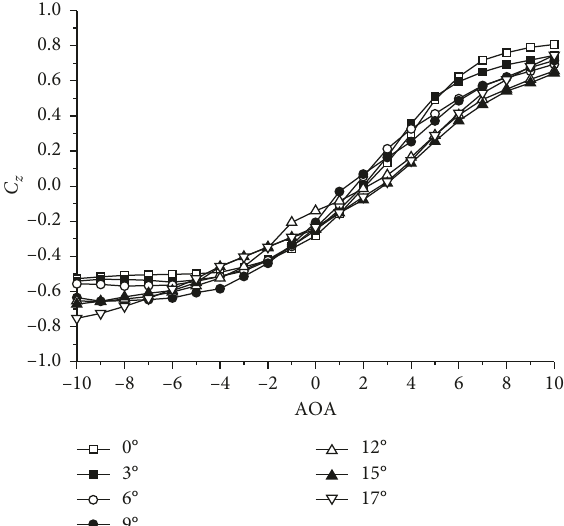
Figure 14: C z vs. AOA for various box slope